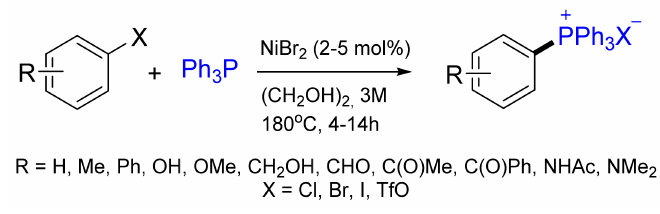
Figure 18. Scope of the Ni-catalyzed C-P coupling.